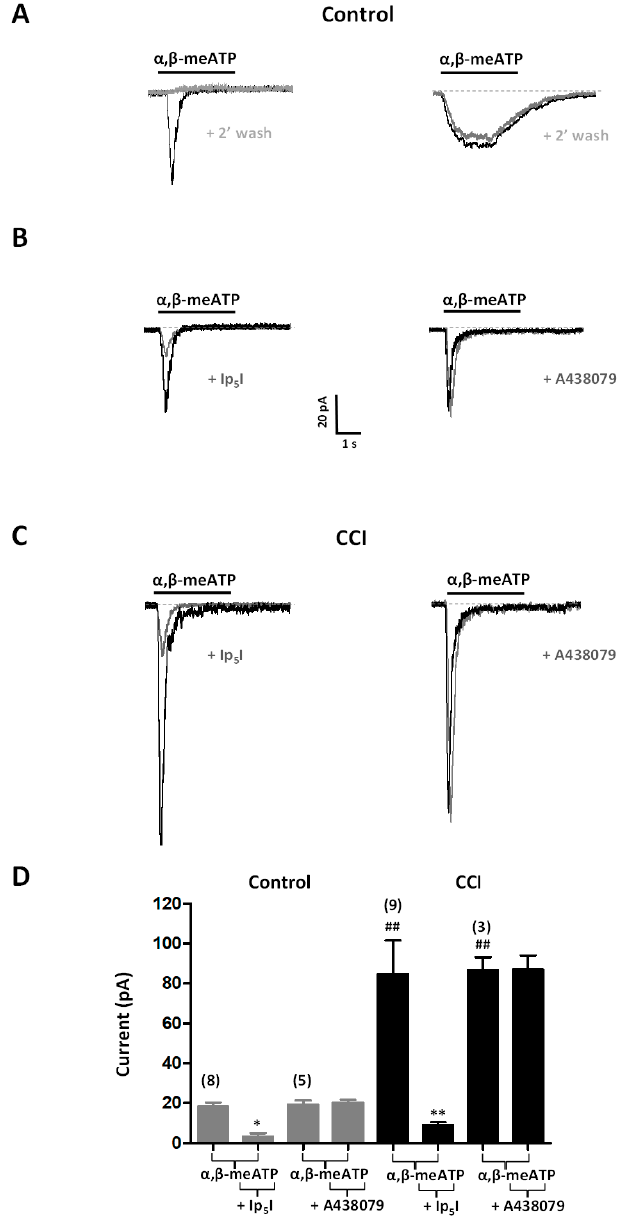
Figure 5. Functional plasticity of P2X3 receptors in chromaffin cells from CCI animals. ( A ) Voltage-clamp recordings of currents evoked by α , β -meATP in chromaffin cells of the adrenal gland from Control animals. The horizontal bars show the application of α , β -meATP (10 µ M, 3 s), which was applied twice with a 2 min interval (+2’ wash). Representative recordings of rapidly desensitizing (left panel) and non-desensitizing (right panel) currents. ( B ) Sensitivity to Ip 5 I or to A438079 (a selective P2X7 receptor blocker) of currents evoked by α , β -meATP in chromaffin cells from Control animals. Horizontal bars show application of α , β -meATP (10 µ M, 3 s), which was applied twice with a 10 min interval, in the absence or the presence of Ip 5 I (+Ip 5 I; 10 µ M, 2 min; left panel) or A438079 (+A438079; 10 µ M, 2 min; right panel). ( C ) Similar to B but referred to CCI animals. Scale bars apply to panels ( A – C ). ( D ). Amplitudes of 10 µ M α , β -meATP-evoked currents in chromaffin cells from Control and CCI animals in the absence and the presence of Ip 5 I (+Ip 5 I; 10 µ M) or A438079 ((+A438079; 10 µ M). Data from the number of cells are shown between parentheses on top of bars. Statistical significances were assessed by a Student t test for paired data when evaluating the effect of receptor antagonists (*, p < 0.05; **, p < 0.01), and for unpaired data when evaluating the effect of CCI ( ## , p <